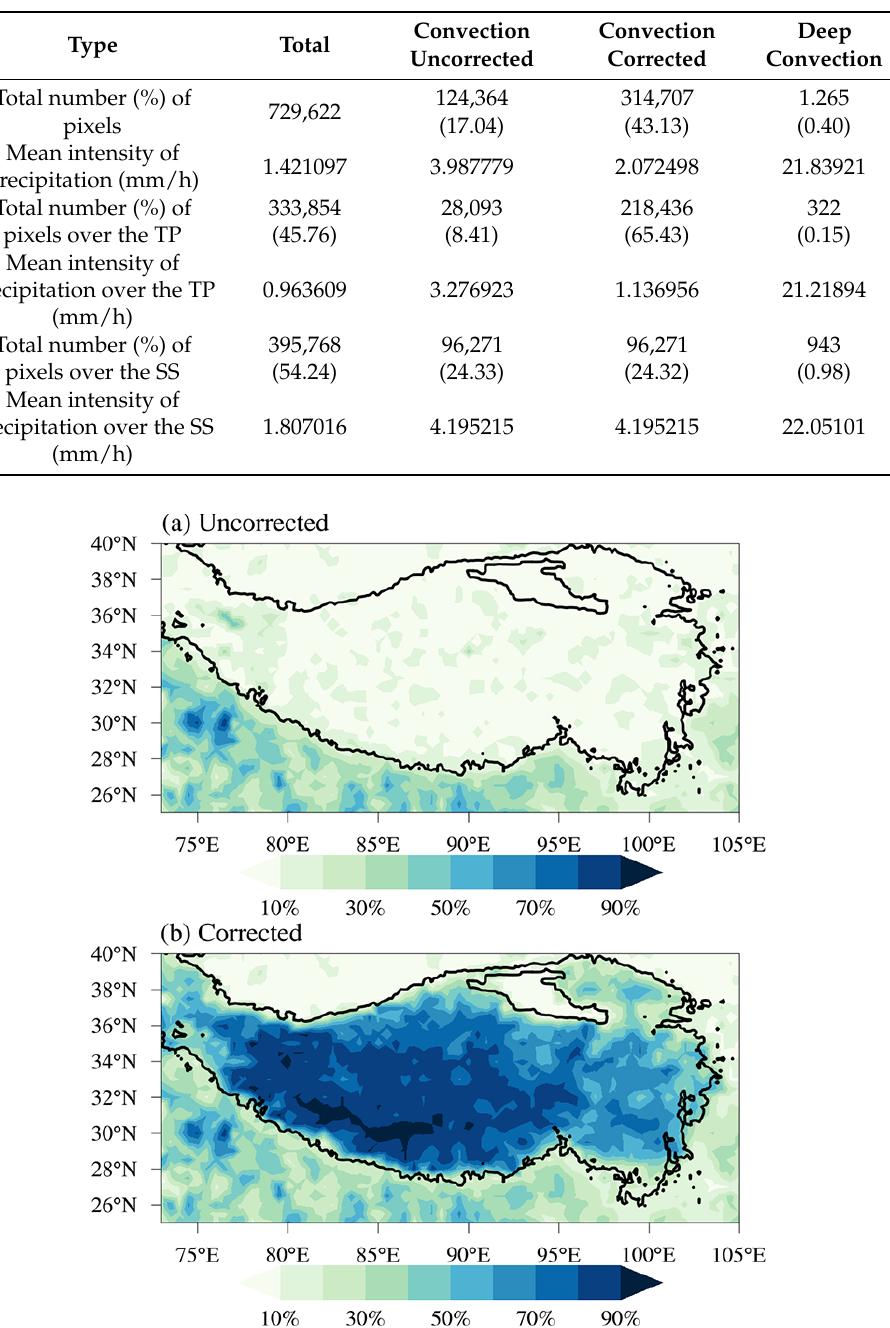
Table 2. Number, percentage and mean intensity of convective precipitation in pixels for different types of precipitation before and after correction.